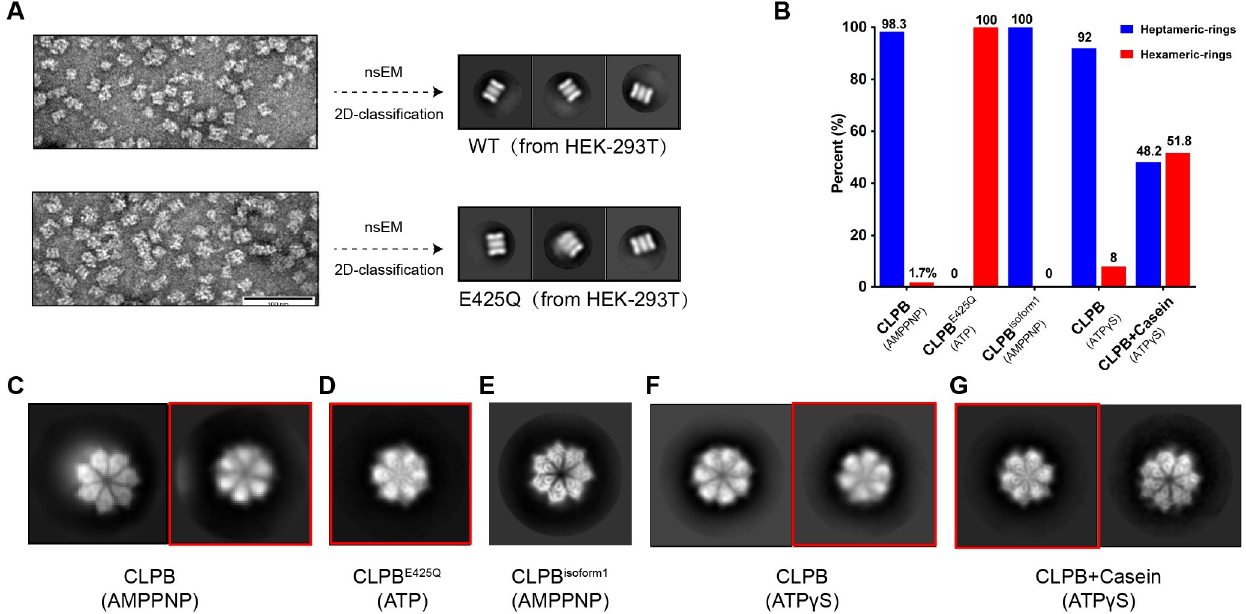
Fig 2. The CLPB double-heptamers transform into double-hexamers upon substrate binding. ( A ) CLPB complexes purified from HEK293 cells form double-oligomeric state. Representative nsEM images (left) and 2D classification averages of nsEM particles (right) of CLPB and CLPB E425Q from HEK- 293T cells. ( B ) The proportion of the hexameric and heptameric top views in the CLPB-AMPPNP, CLPB E425Q -ATP, CLPB isoform1 -AMPPNP, CLPB-ATP γ S, and CLPB+Casein-ATP γ S datasets (S2 Data). ( C–G ) Representative top views of 2D classification averages of CLPB-AMPPNP (C), CLPB E425Q -ATP (D), CLPB isoform1 -AMPPNP (E), CLPB-ATP γ S (F), and CLPB+Casein-ATP γ S (G) datasets. The top views with hexameric feature are indicated by red boxes. nsEM, negative staining electron microscopy.